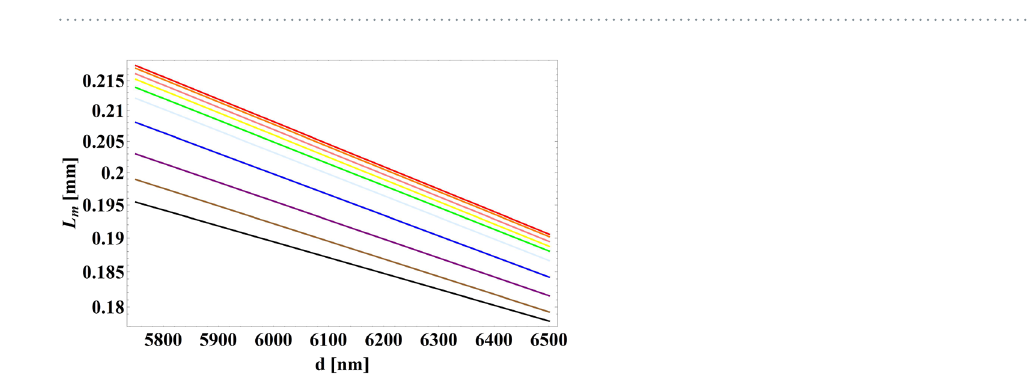
Figure 4. Optical force versus waveguide’s diameter for different gap sizes for ( a ) semi-insulating InP waveguide above a glass substrate and ( b ) Si waveguide above a glass substrate at λ 0 = 20 µ m.